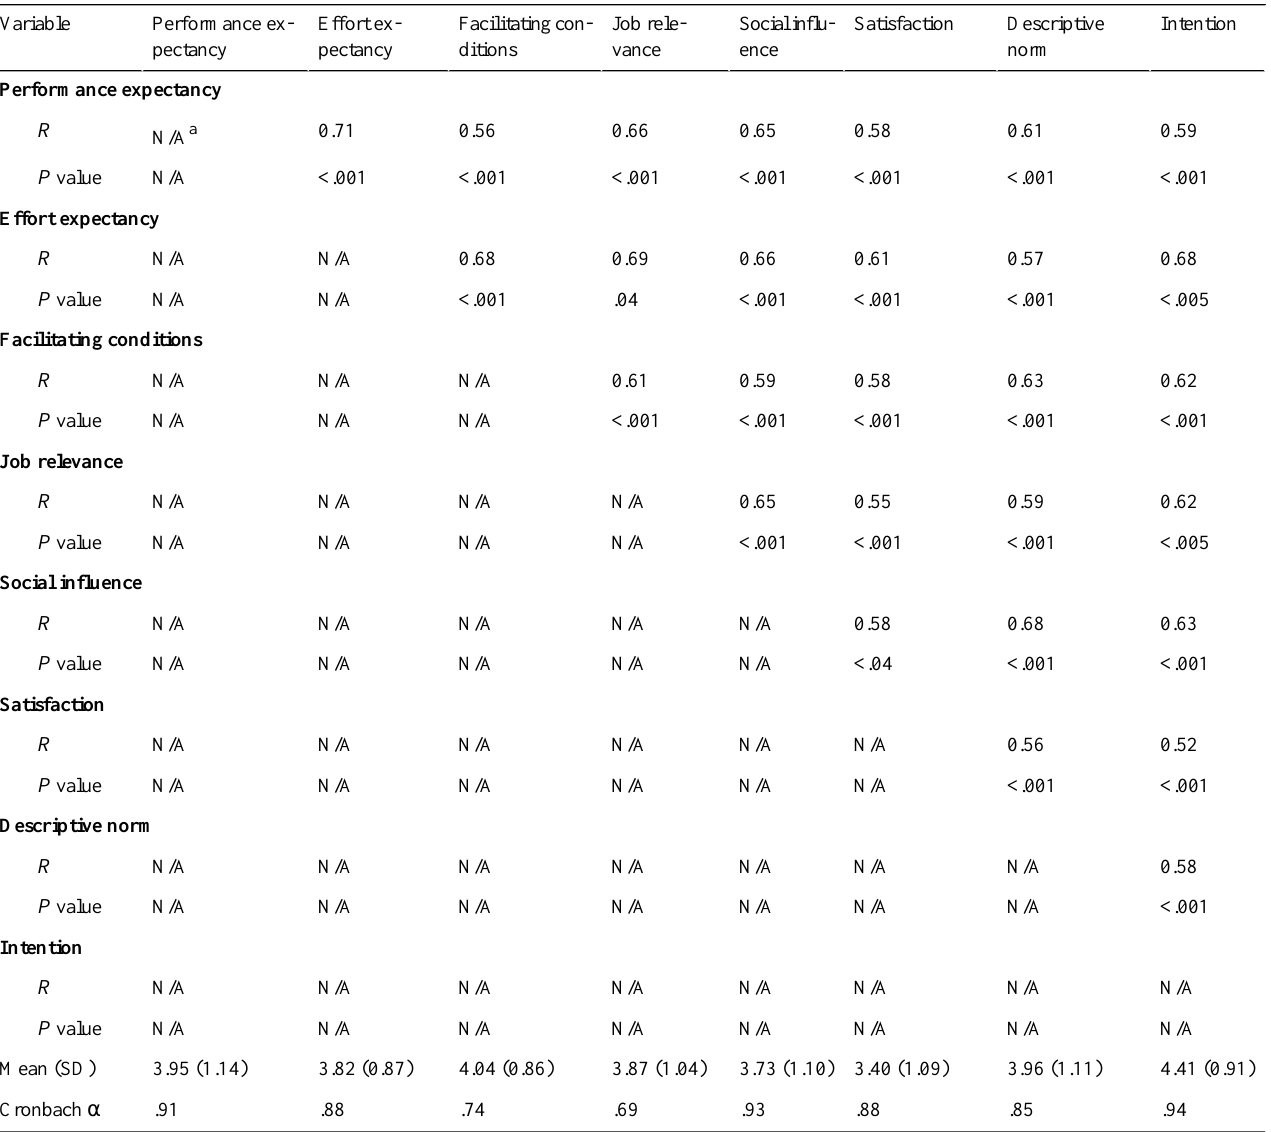
Table 1. Spearman rank